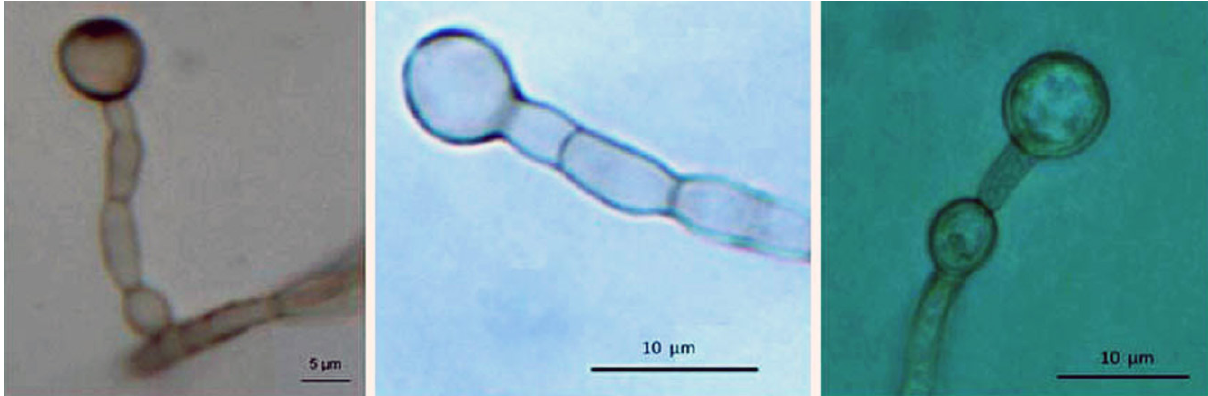
Figure 3. Fonsecaea pedrosoi terminal roundish-cell observed in vitro after a week of co-culturing with B. subtilis strain ,